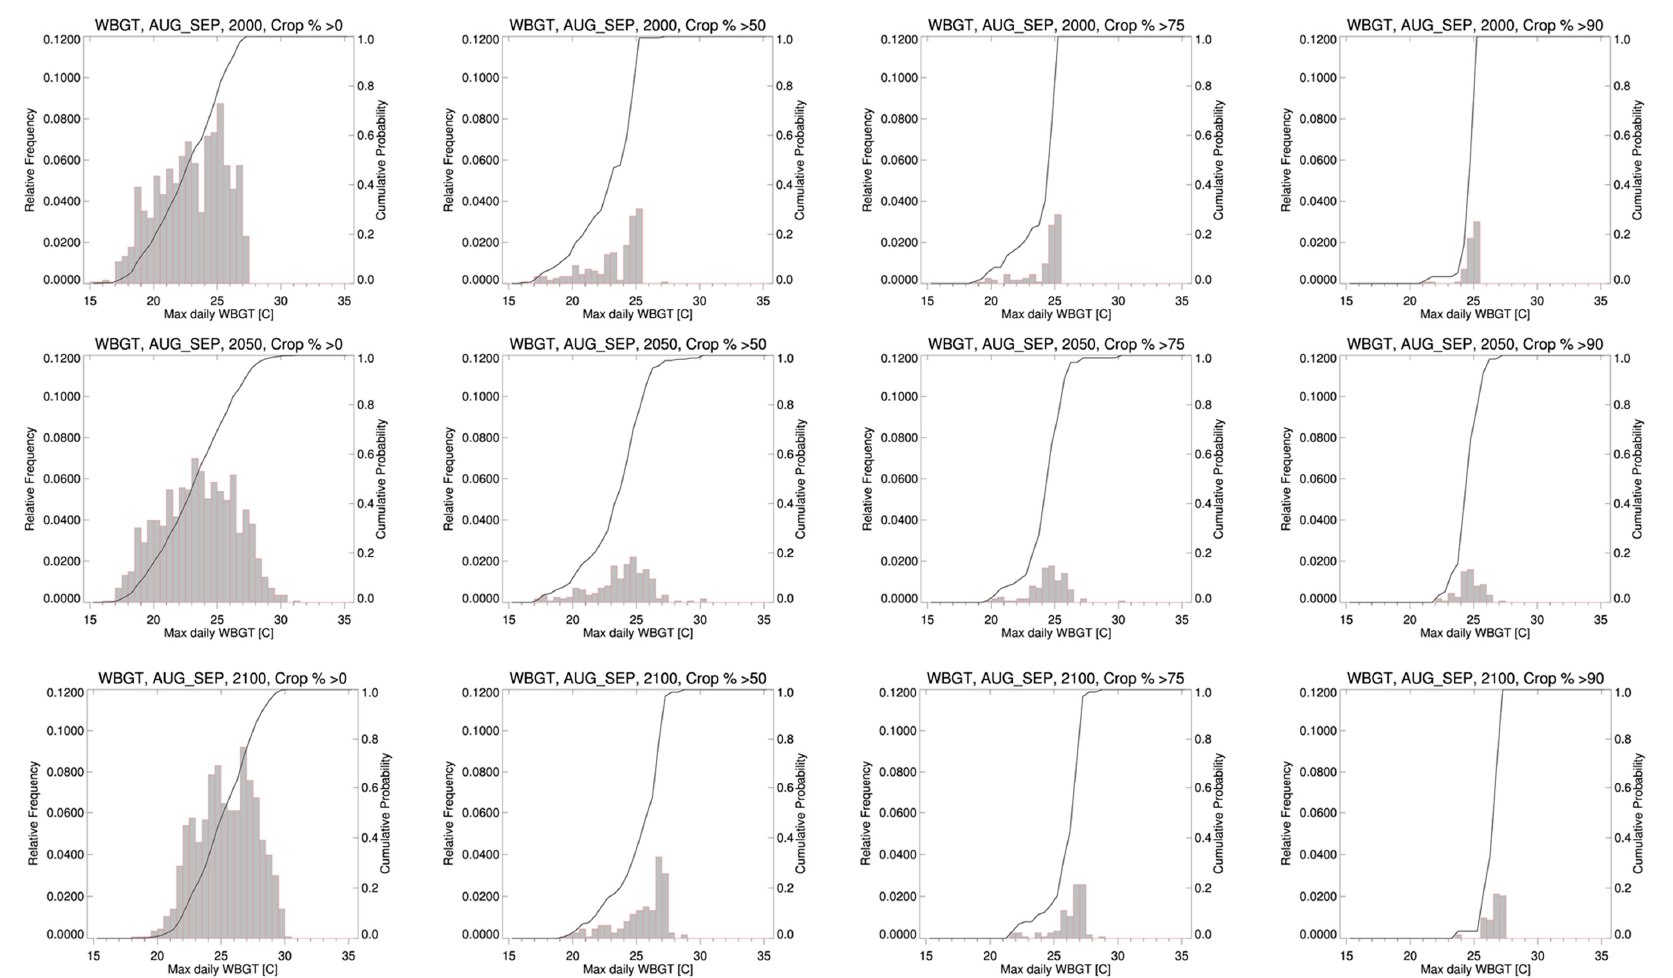
Figure 5. Frequency distribution and cumulative probability of WBGT and varying cropping intensities for August–September 2000, 2050, and 2100.